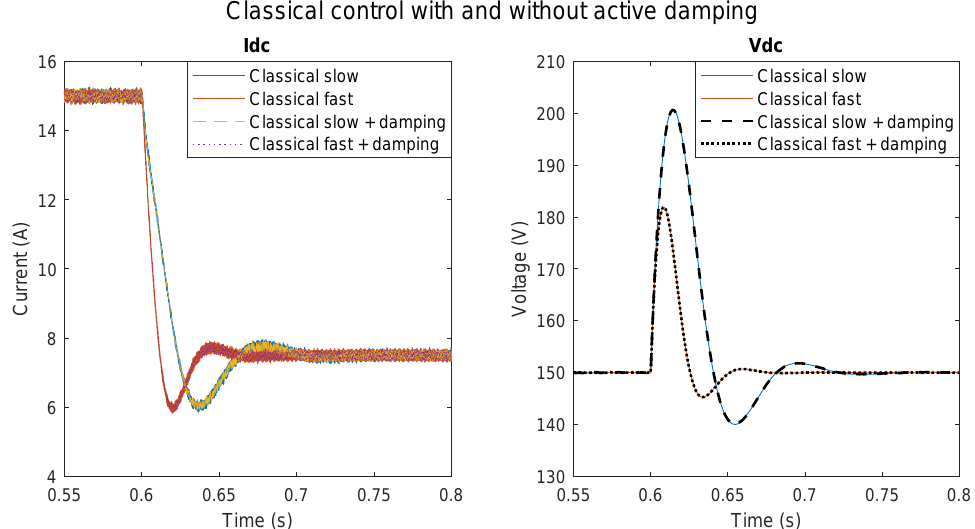
Figure 14. Simulation results of the classical control with and without active damping method: behavior of the output current ( I dc ) and voltage ( V dc ) during a load step from 10 Ω to 20 Ω . Grid voltage is at 110 V. Parameters are listed in Tables 3 and 4.